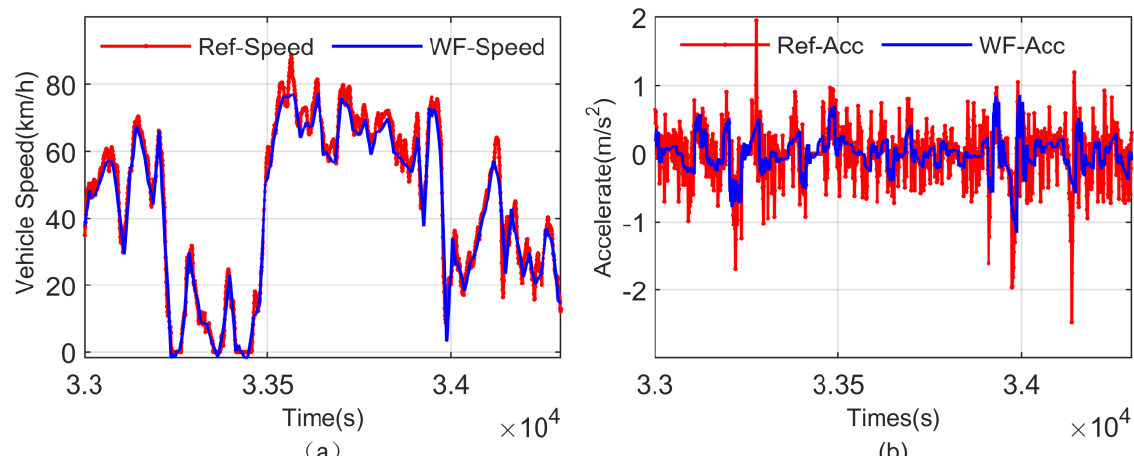
Figure 4. Partial perspective view of wavelet denoising. ( a ) Vehicle speed; ( b )